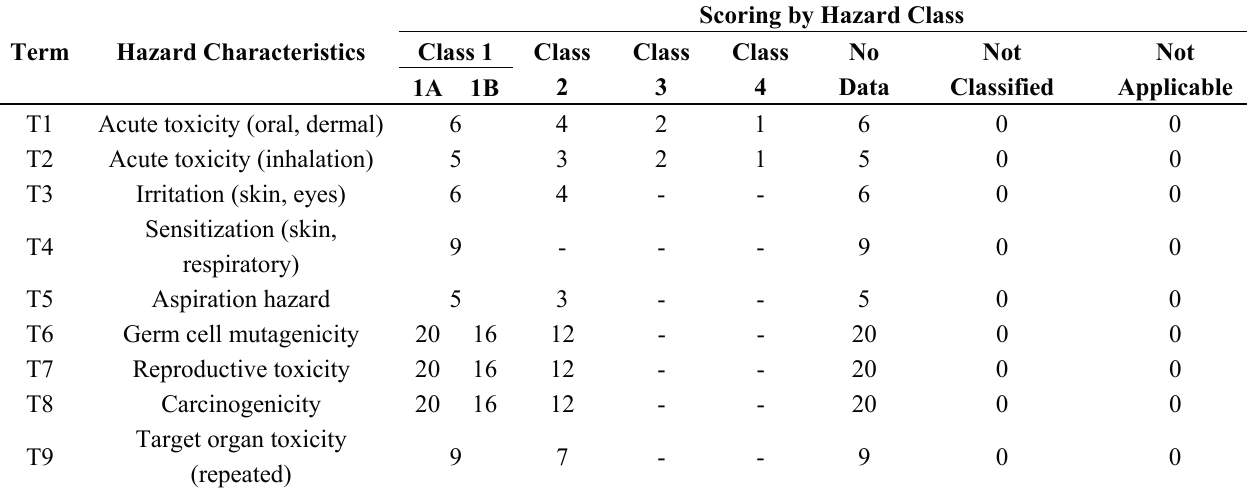
Table 2. Scoring for the classification of hazard